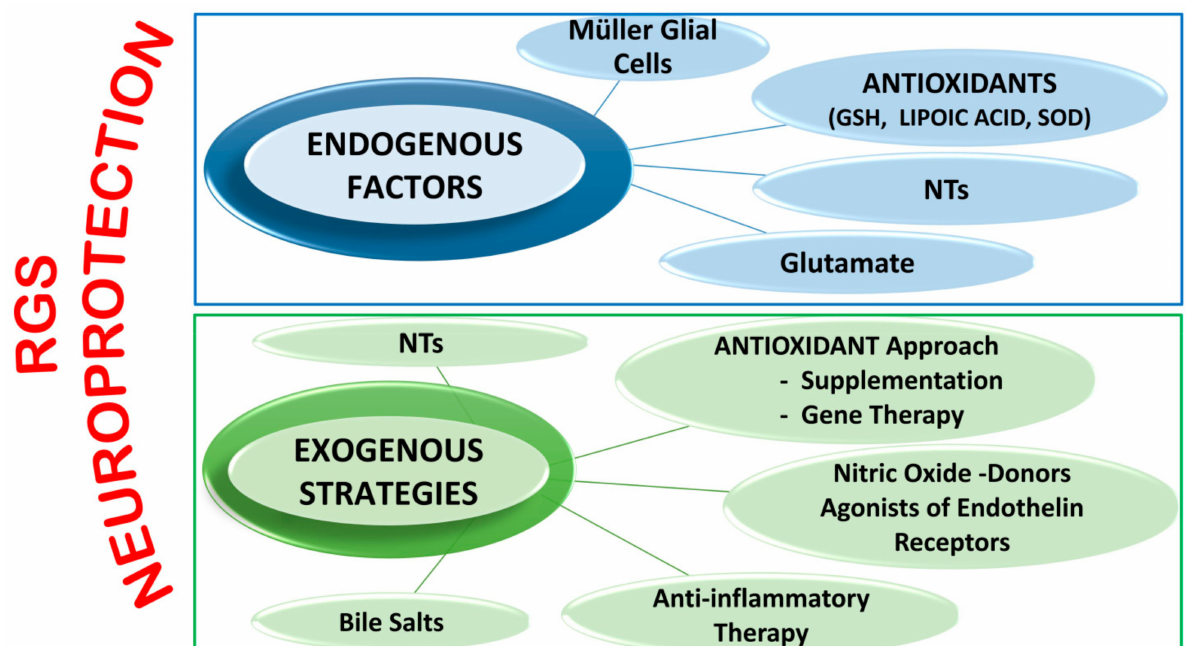
Figure 3. Neuroprotective mechanisms for preventing and slowing down RGC diseases. Endogenous factors include Müller Glial Cells functions, antioxidant systems, NTsand